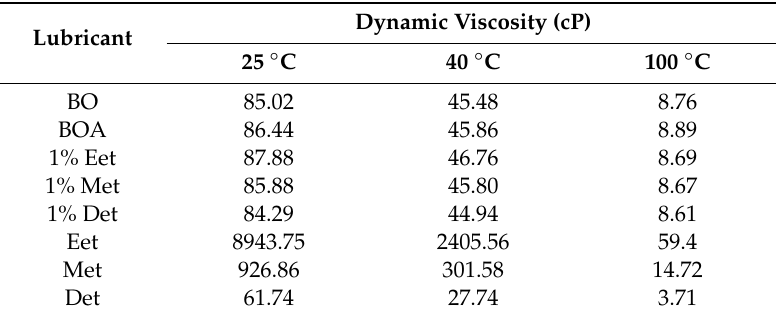
Table 4. The viscosity of BO, BOA, neat PILs, and PIL blends.